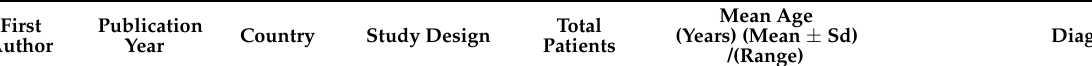
Table 4. Animal experimental studies assessing artificial intelligence-based